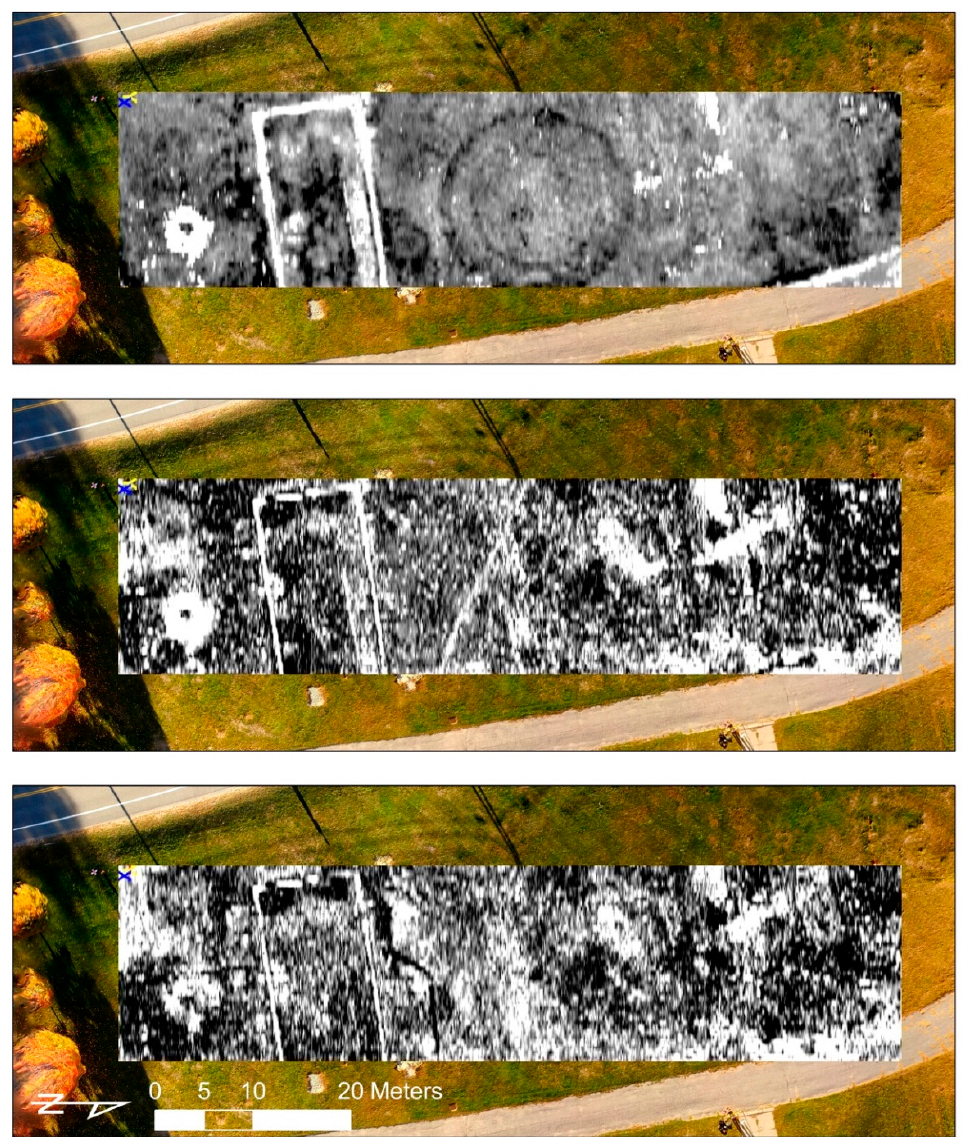
Figure 11. GPR data from the main lawn at the Enfield Shaker Village, 23 October 2017. ( left ) 15 cm below surface; ( center ) 30 cm below surface; ( right ) 50 cm blow surface.